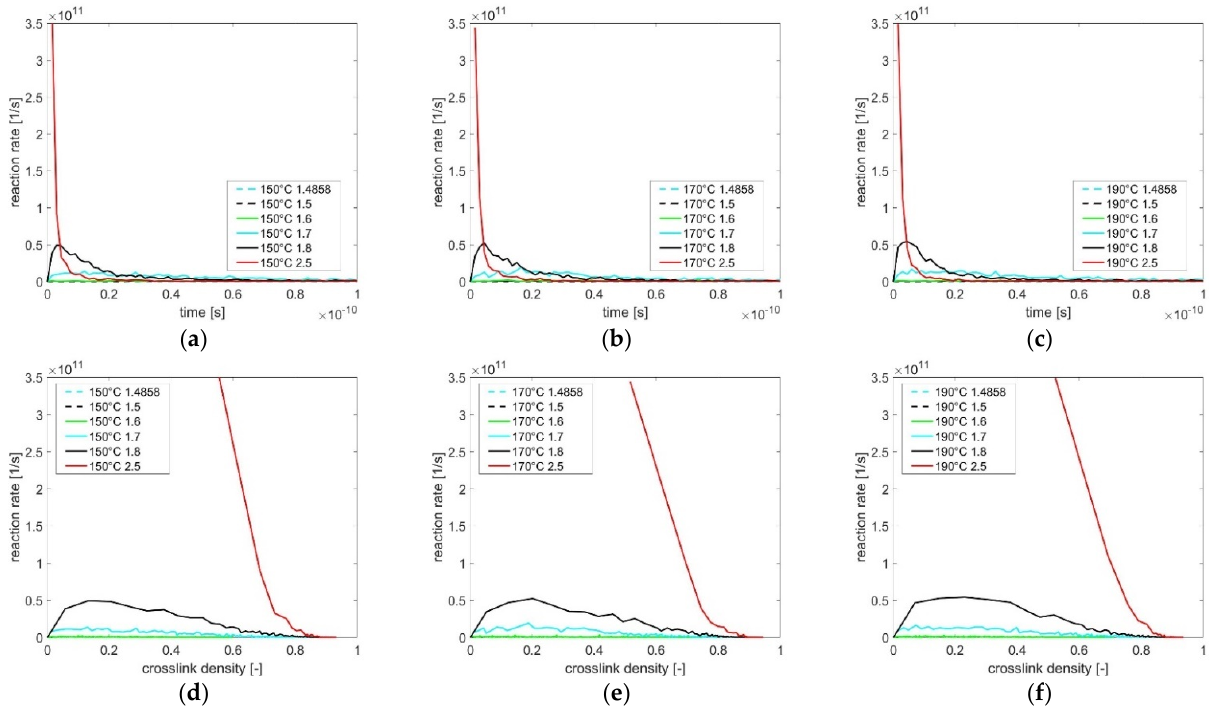
Figure 6. ( a – c ) Curves of reaction rate depending on curing time and ( d – f ) curves of reaction rate depending on crosslink density concerning the influence of cutoff distance (1.48 Å → 2.5 Å) at 150 °C, 170 °C, and 190 °C.